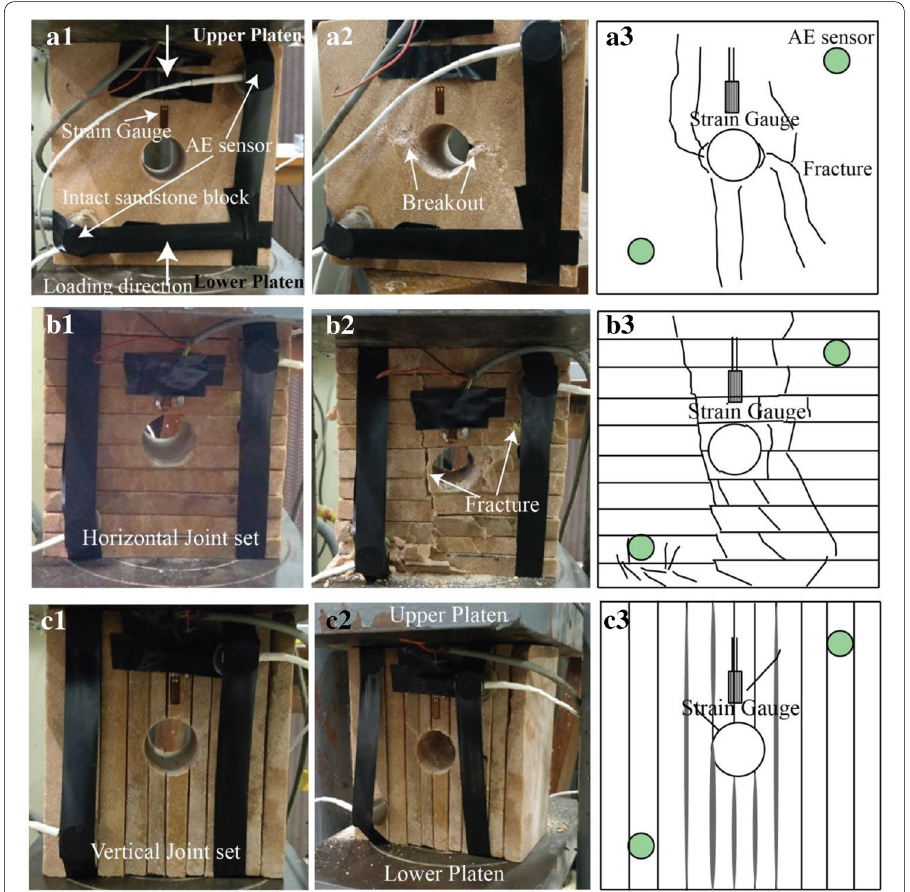
Fig. 4 Representative photos of cracking damages of the rock blocks with illustrations for all three cases i.e. intact rock block ( a1 , a2 , and a3 ), block with horizontal joint set ( b1 , b2 and b3 ) and block with vertical joint set ( c1 , c2 , and c3